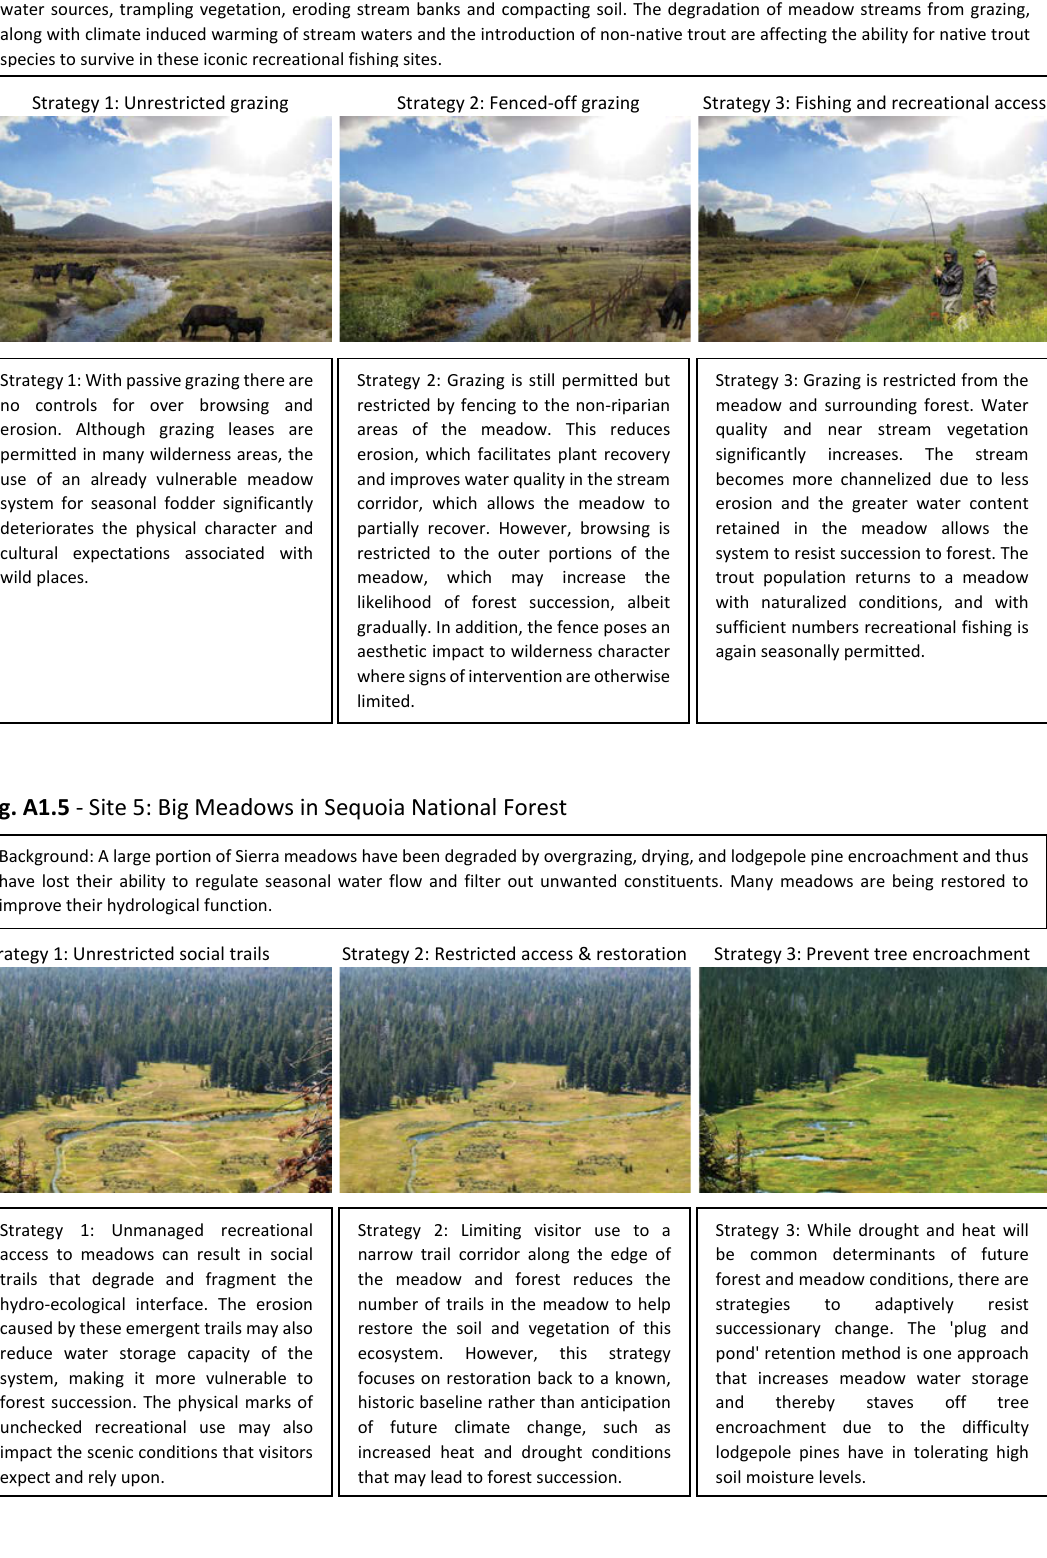
Fig. A1.4 - Site 4: Templeton Meadows in the Gold Trout Wilderness